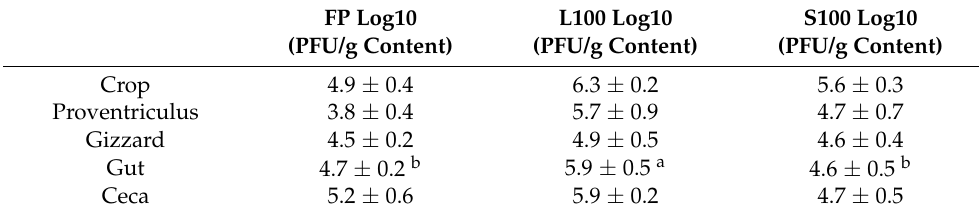
Table 2. In vivo comparation of BP treatments (FP, L100 and S100) within each GIT